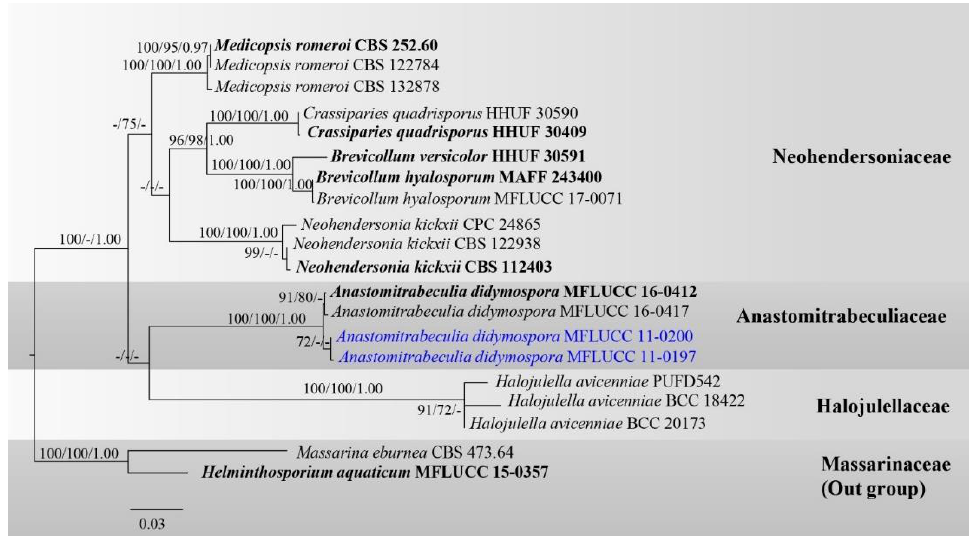
Figure 1. Phylogram generated from RAxML analysis of a concatenated LSU-SSU-ITS- tef1- α sequence dataset to represent the phylogenetic relationships of taxa in Anastomitrabeculiaceae, Halojulellaceae, and Neohendersoniaceae. Bootstrap support values for ML and MP equal to or greater than 70% and the Bayesian posterior probabilities equal to or higher than 0.95 PP are indicated above the nodes as ML/MP/PP. Support values lower than 70% ML/MP and 0.95 PP are indicated by a hyphen (-). Ex-type strains are in bold and the newly generated sequences are indicated in blue.